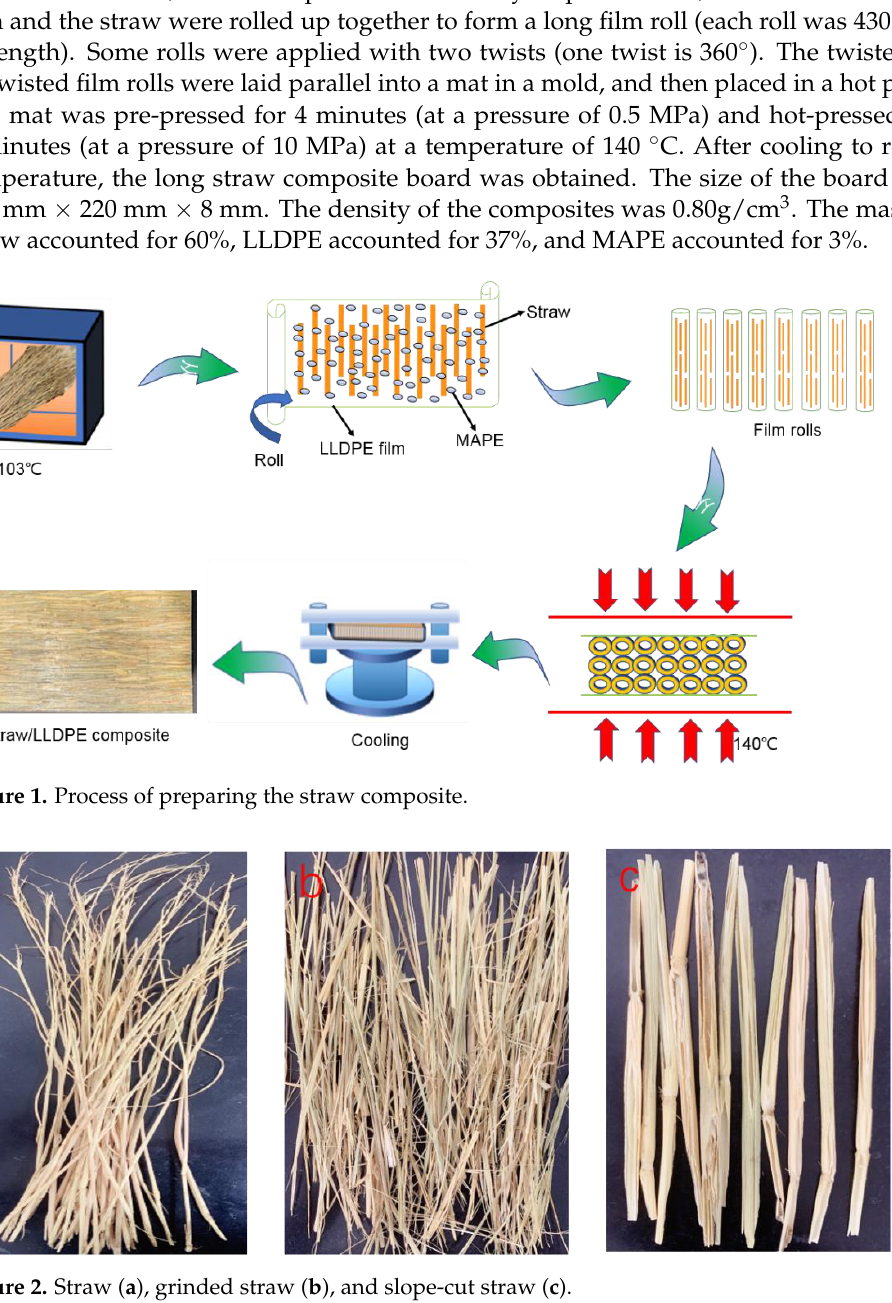
Figure 2. Straw ( a ), ground straw ( b ), and slope-cut straw ( c